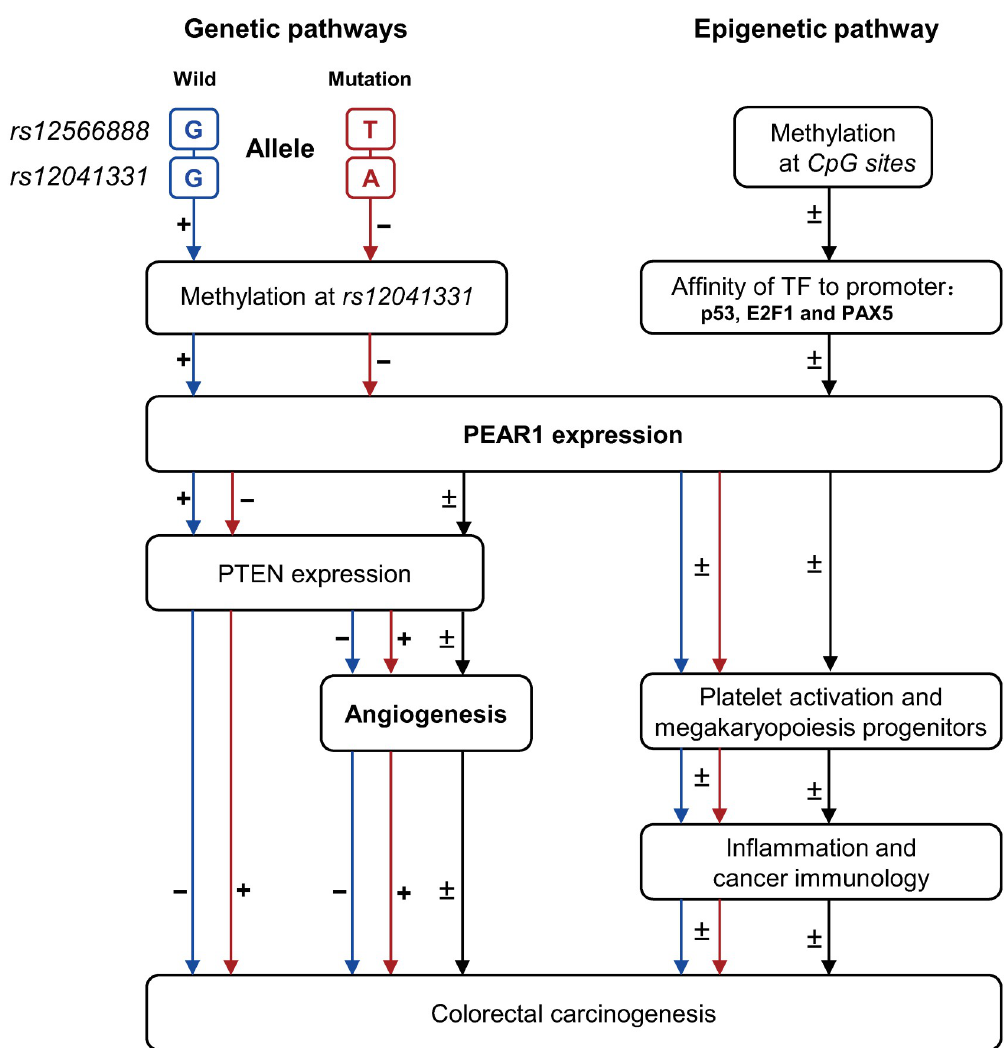
Fig 5. Potential pathways involved in the pathogenesis of colorectal cancer in relation to rs12566888 and methylation status at CpG sites 2, 11, 12 and 13 in the PEAR1 promoter. p53, PAX5, and E2F-1 are transcription factors identified in the in-silico analysis. PTEN represents phosphatase and tensin